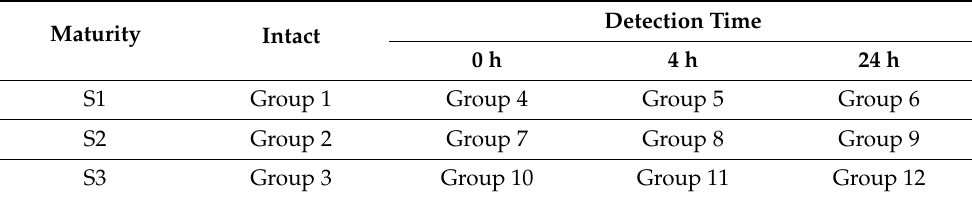
Table 1. Grouping introduction of the total twelve groups *.